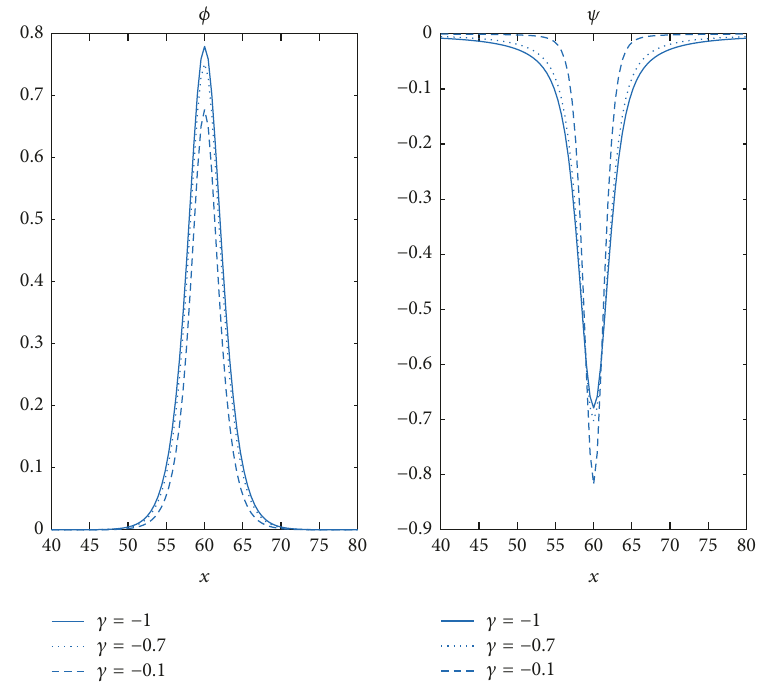
Figure 16: Comparison of solitary wave solutions of the SBO system for different values of the parameter 𝛾 .